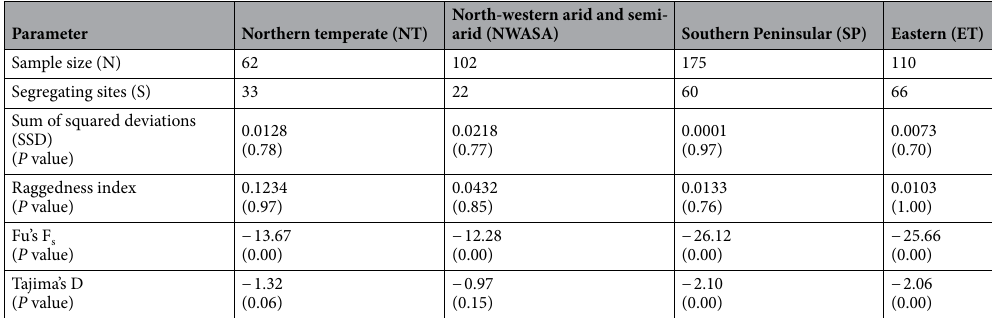
Table 2. Population demographic parameters and neutrality tests for Indian sheep populations.